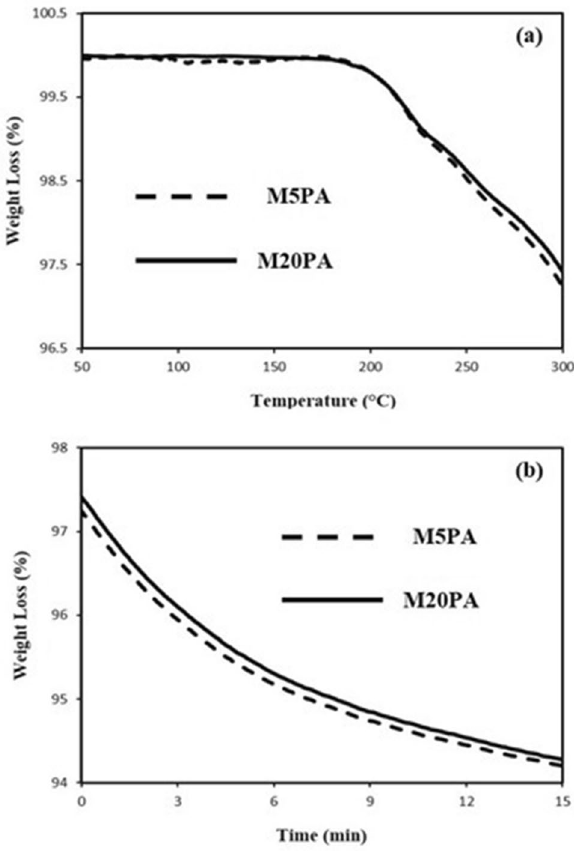
Fig. 6 TGA diagrams of M5P and M20P samples at a 300 ◦ C and b 15-min holding at 300